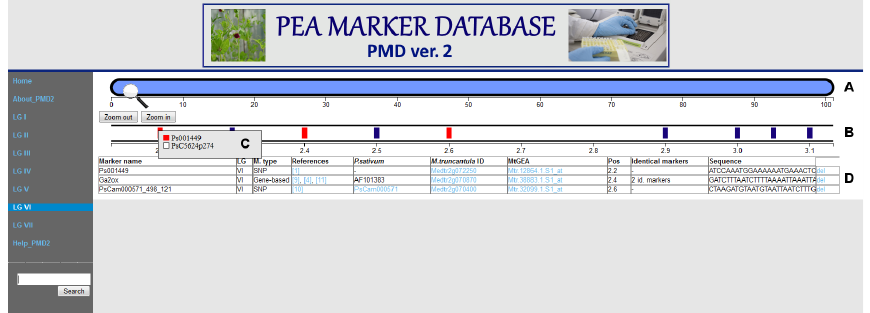
Fig 4. Interface of PMD2. (A) General view of selectedLG. (B) Scaled regionof selectedLG. Previously selectedloci are coloredin red. (C) Markers situated in selectedlocus. (D) Table containinginformation about